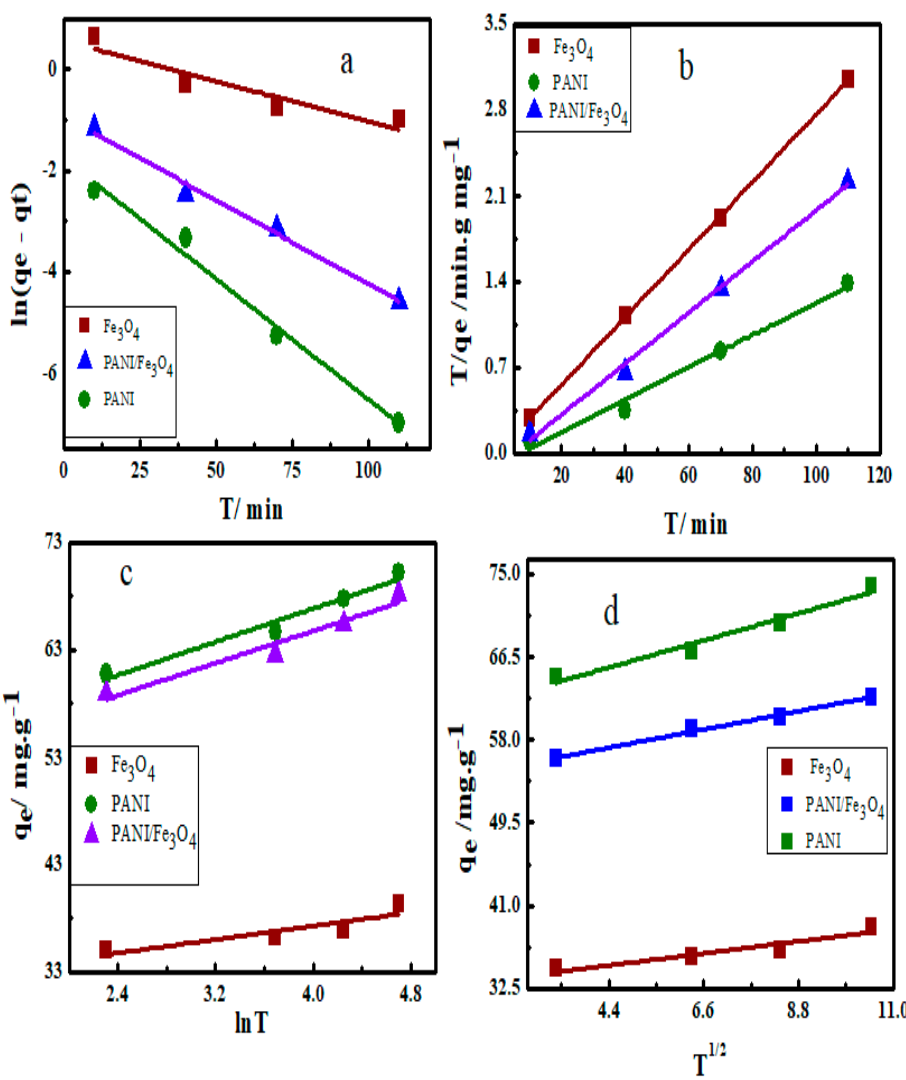
Figure 11. The Kinetics model ( a ) pseudo-first-order, ( b ) pseudo-second-order, ( c ) Elovich model and ( d ) intra-particle diffusion model for adsorption of AB40 on Fe 3 O 4 , PANI and PANI/Fe 3 O 4 composite . Table 3. Kinetics parameters for adsorption of AB40 on Fe 3 O 4 , PANI and PANI/Fe 3 O 4 composite based on pseudo-first-order and pseudo-second-order equations.